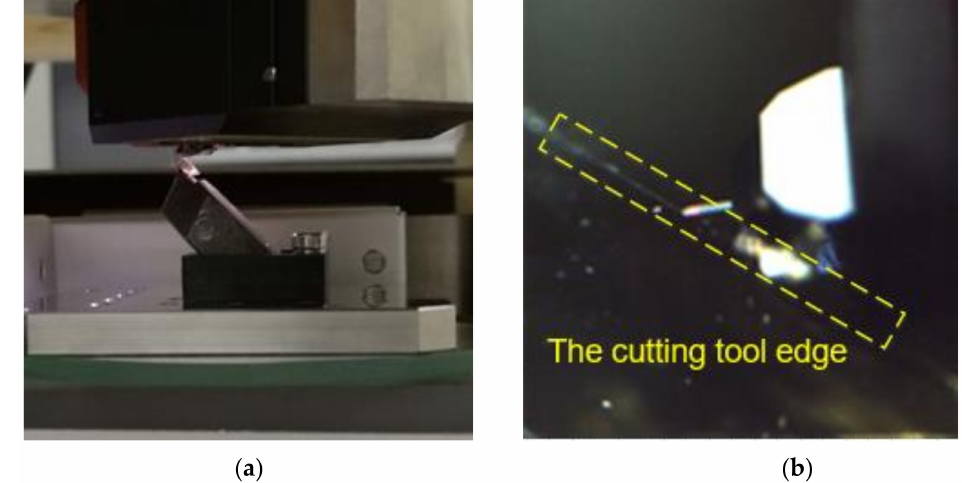
Figure 15. Measurement of a cutting tool: ( a ) Fix of the cutting tool sample; ( b ) Micrograph of the cutting edge being